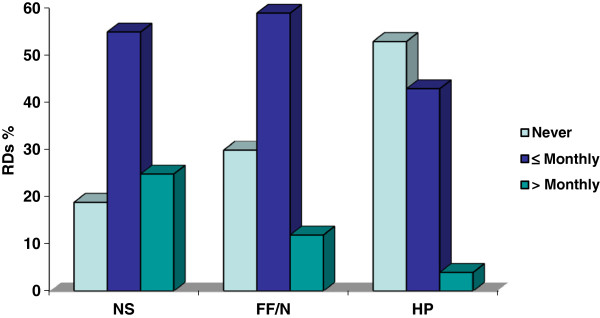
Demand for Dietetic Expertise: Colleagues Consulting with RD.